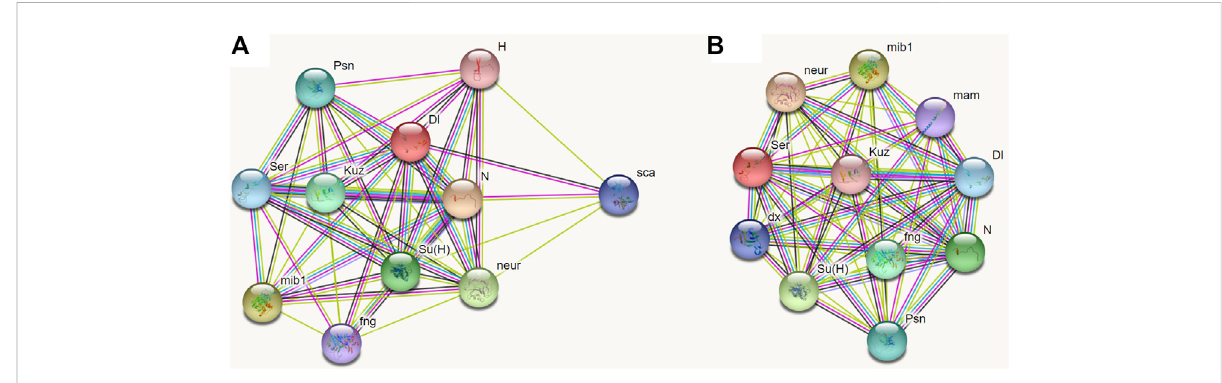
FIGURE 10 Prediction of interacting proteins of Delta and Serrate in Drosophila melanogaster by STRING analyses. (A) : Interacting proteins of Delta. (B) : Interacting proteins of Serrate. Note: N, Notch; mib1, Mind-bomb; neur, Neuralized; Su(H), Suppressor of hairless protein; Kuz, Kuzbanian; Psn, Presenilin; Ser, Serrate; fng, Fringe; Dl, Delta; sca, Scabrous; H, Hairless; dx, Deltex; mam,